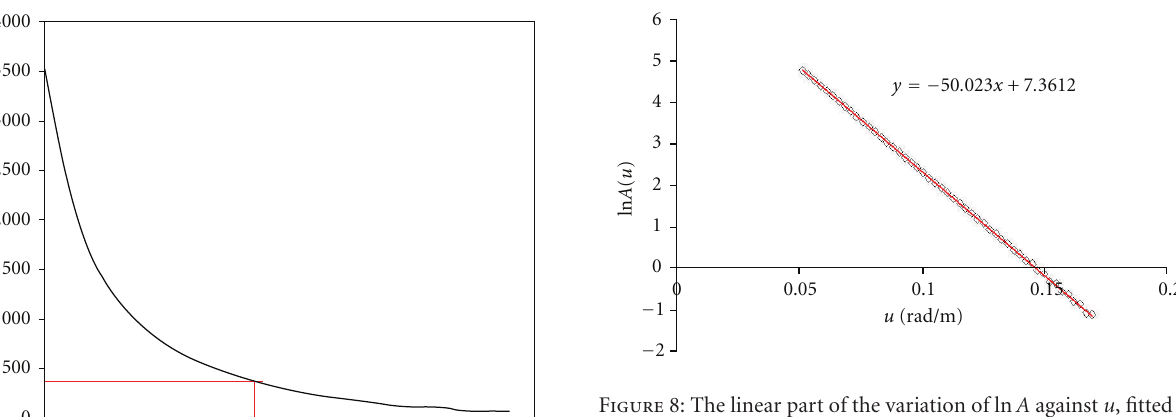
Figure 8: The linear part of the variation of ln A against u , fitted by the least squares line.